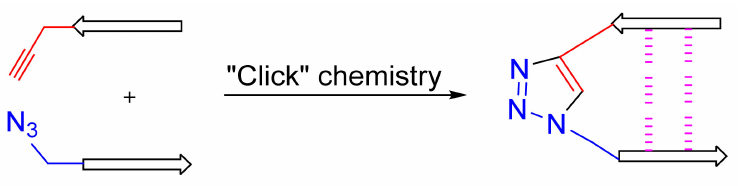
Figure 7. Formation of turns by cycloaddition using “click”